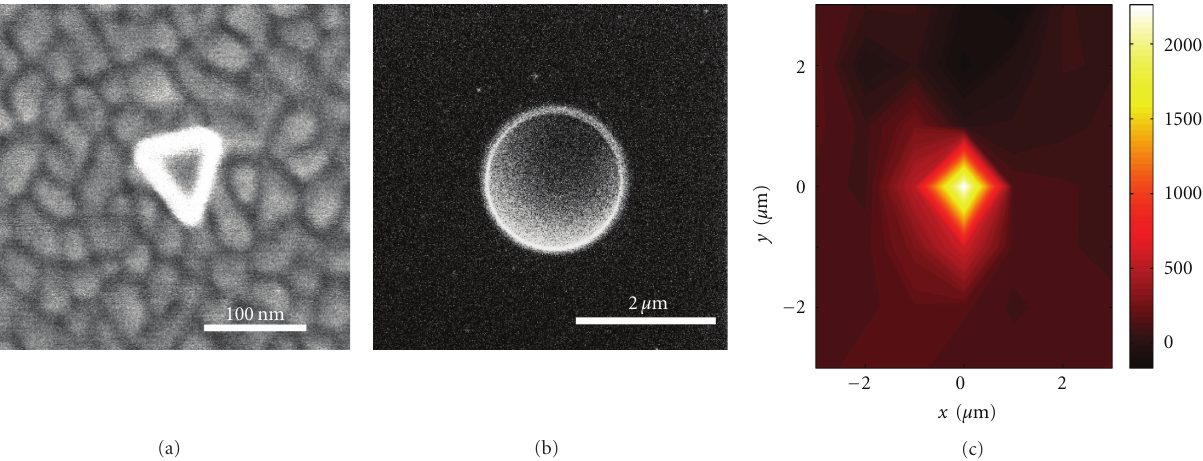
Figure 8: (a) Scanning electron microscopy image of Ag nanoprism. (b) A scanning ion microscope image of the paraboloid drilled on silicon taken directly from the FIB. (c) A 6 × 6 μ m 2 map of the Raman signal around a parabolic reflector